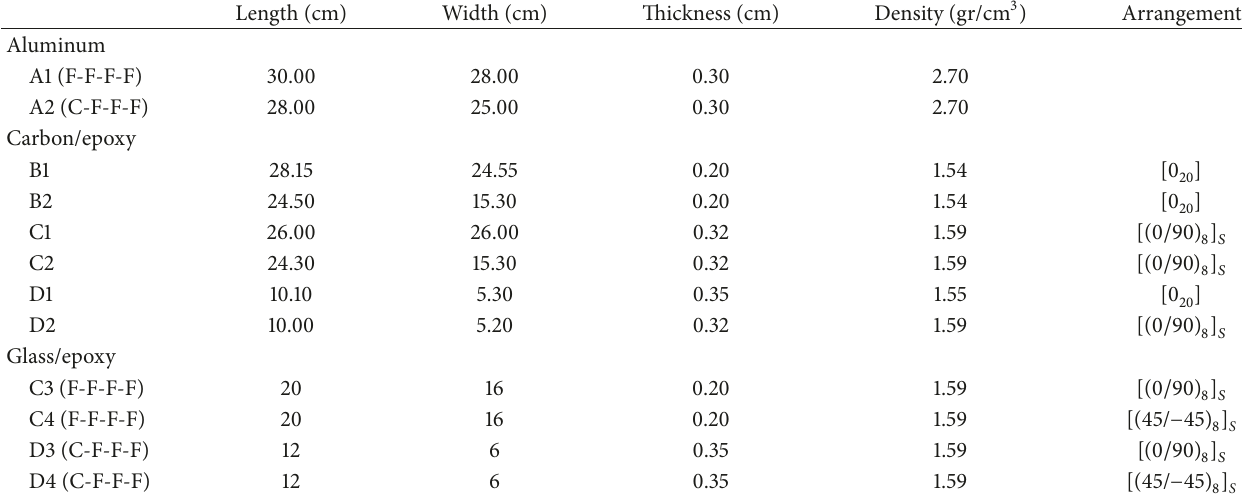
Table 2: Dimensions and density of the aluminum and carbon/epoxy plates [8].